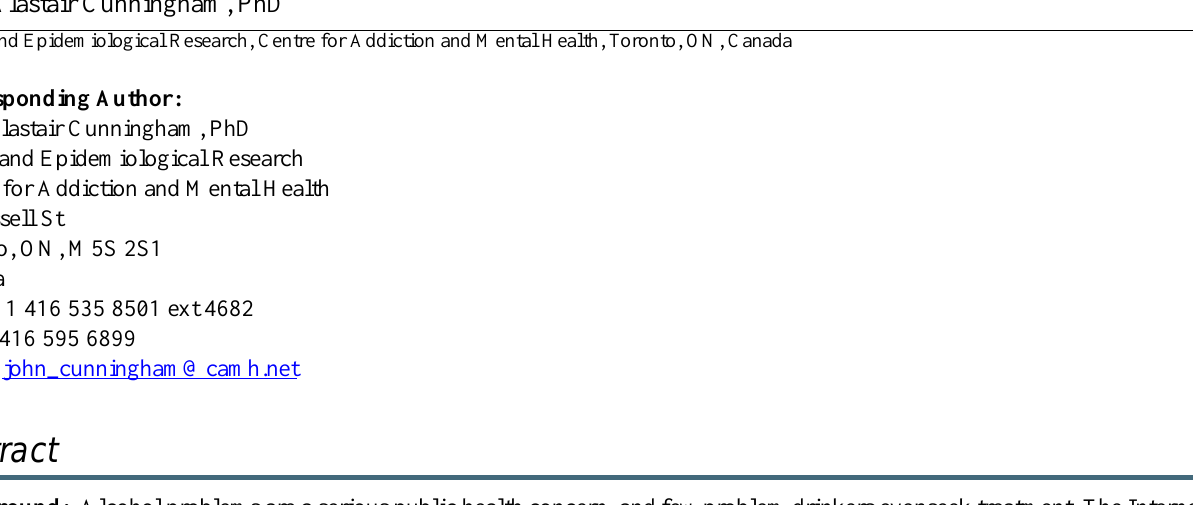
Randomized controlled trial; problem drinking; alcohol abuse; Internet-based intervention; eHealth; brief